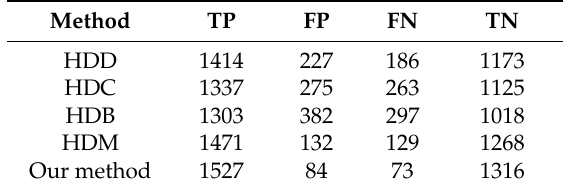
Figure 8. ( a ) Original image. ( b ) Harbor extraction result based on dock. ( c ) Harbor detection result based on coastline closure. ( d ) Harbor detection result based on breakwater. ( e ) Harbor detection result based on model matching. ( f ) Harbor target detection result based on our method. Table 4. True positive (TP), false positive (FP), existing target images (FN) and non-existing target images (TN) of our method and four competing methods.